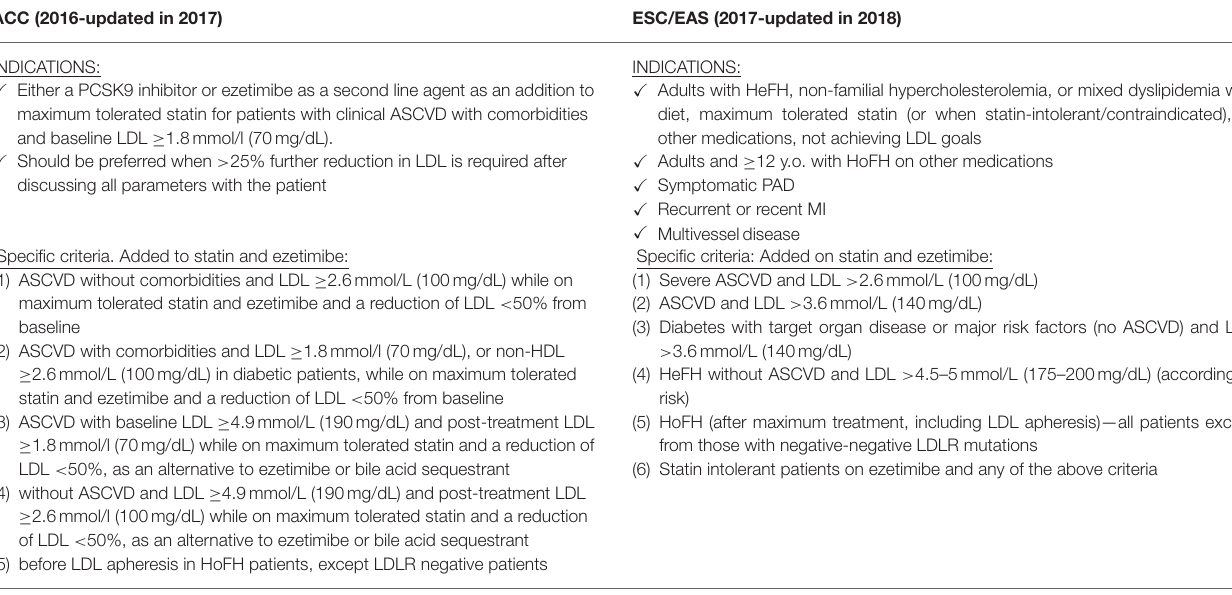
TABLE 10 | European and American Criteria for PCSK9 inhibitor use.